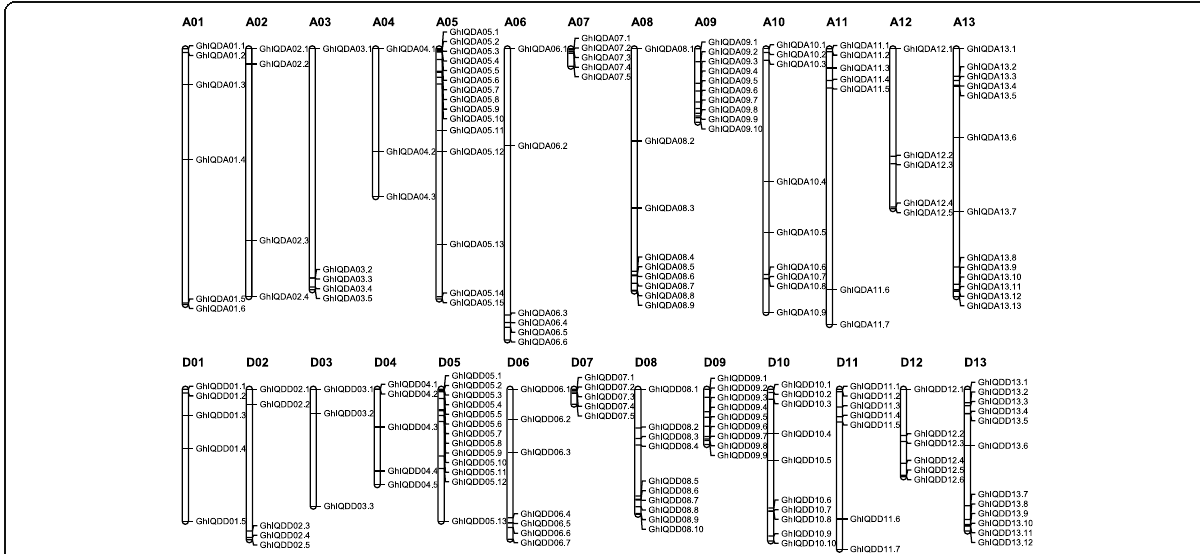
Fig. 1 Chromosomal locations of cotton GhIQD genes on the G. hirsutum L. chromosomes. A01-A13 and D01-D13 indicate chromosomes from the A-subgenome and D-subgenome, respectively. The chromosome number is shown above each chromosome, and the relative locations of the GhIQD genes are indicated on the